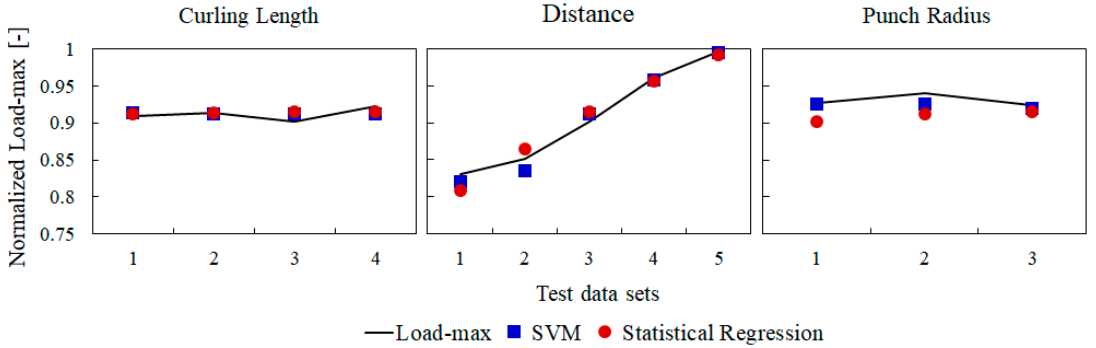
Figure 15. Normalized Load-max vs. test datasets for different regression methods.